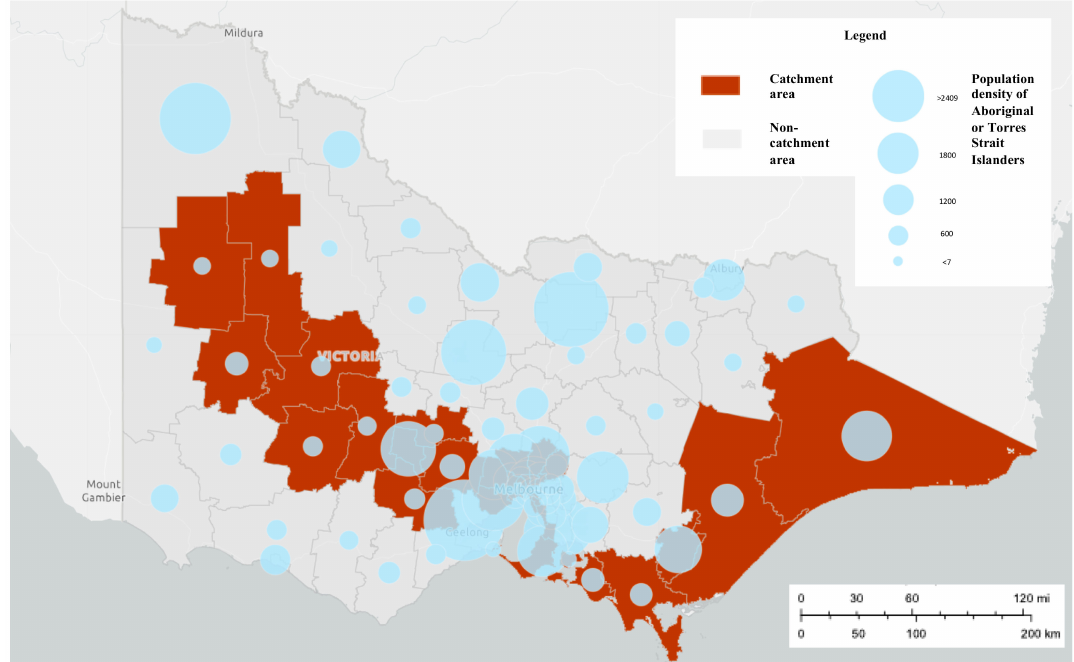
Figure 3. Population density of persons from Aboriginal or Torres Strait Islander backgrounds in the catchment areas of the Self-Harm Monitoring System for